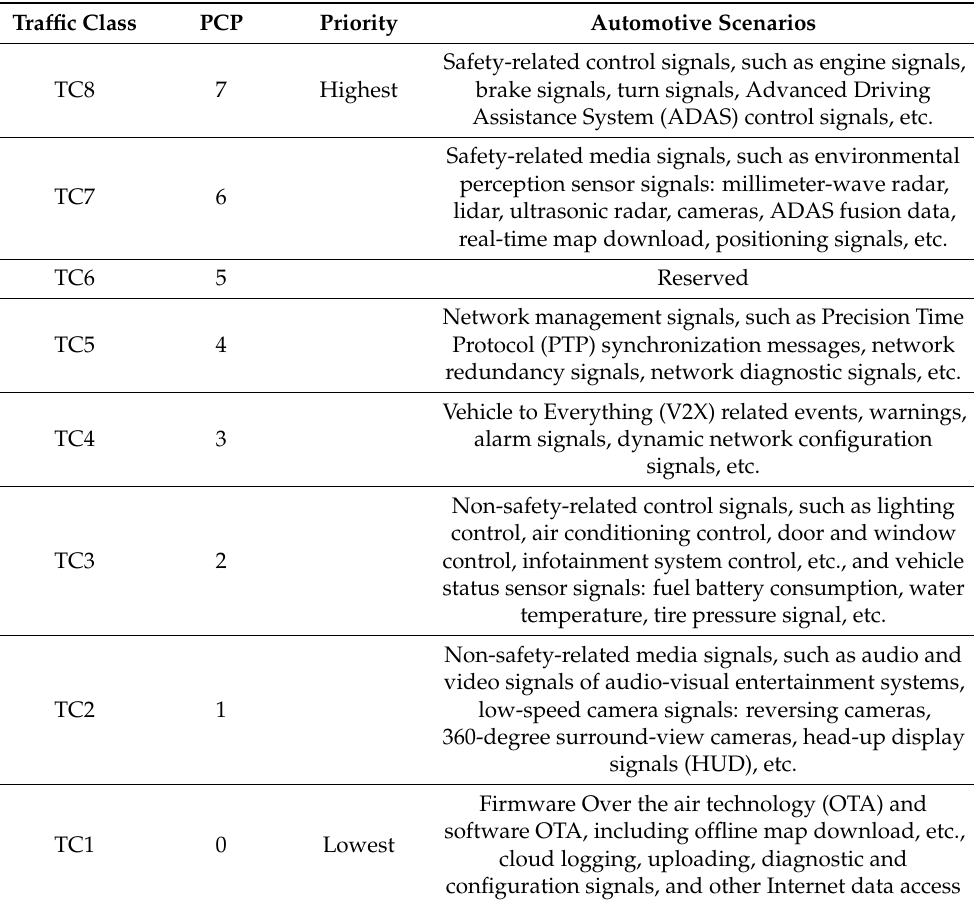
Table 4. Correspondence between traffic types and automotive